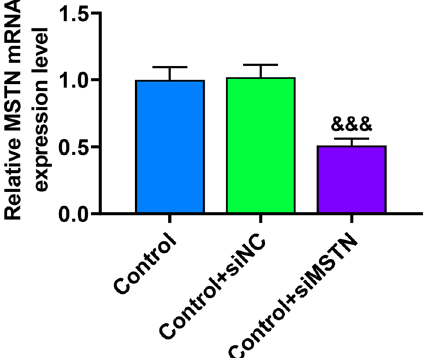
Figure A1: E ff ects of siMTSN on the expression of MTSN in AB8/13 cells. &&& p < 0.001 vs. control + siNC. Abbreviation: MSTN, myos - tatin; siMSTN, small interfering RNA targeting MSTN; siNC, siRNA negative